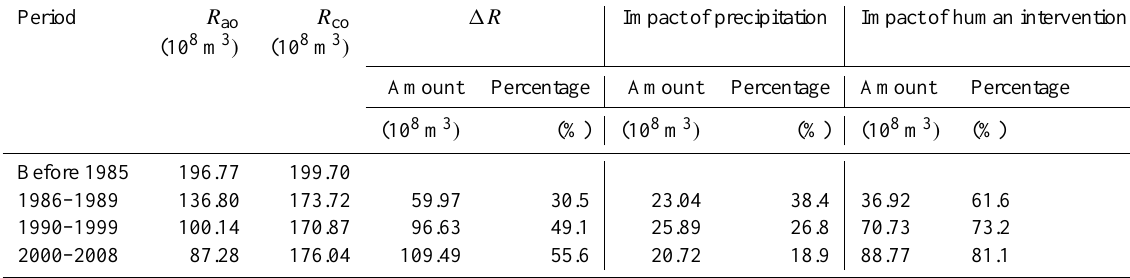
Table 7. The impact of precipitation and human intervention on annual sediment discharge decline in the MRYR basin. Period S ao S co 1S Impact of precipitation Impact of human intervention (10 8 t) (10 8 t) Amount Percentage Amount Percentage Amount Percentage (10 8 t) (%) (10 8 t) Befor